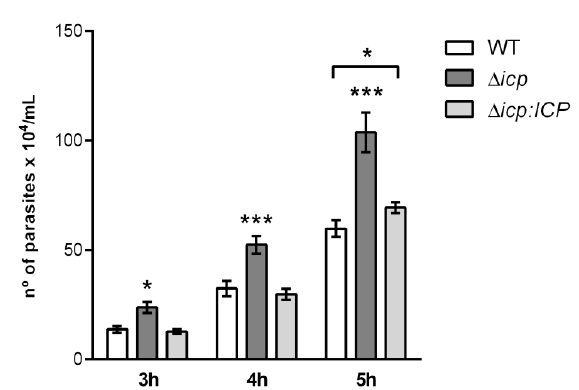
Figure 4. T. b. rhodesiense Δ icp transmigrate an in vitro blood–brain barrier model more efficiently than wild type. Human brain microvascular endothelial cells (HBMECs) were seeded (5 × 10 3 ) on top of Transwell inserts with 3 μ m pores and cultured for 5 days, after which BSF parasites (10 6 ) of T. b. rhodesiense WT, Δ icp , and Δ icp:ICP were added on top of the HBMEC-containing inserts. The number of parasites present in the bottom chamber was determined by counting aliquots on a Neubauer chamber after 3, 4, and 5 h of incubation. The experiments were performed in triplicate, three independent times, and data are shown as the mean ± SD of a representative experiment. As- terisks indicate statistical significance at p < 0.05 (*) and p < 0.001 (***) as assessed by two-way ANOVA with Tukey’s post hoc test.